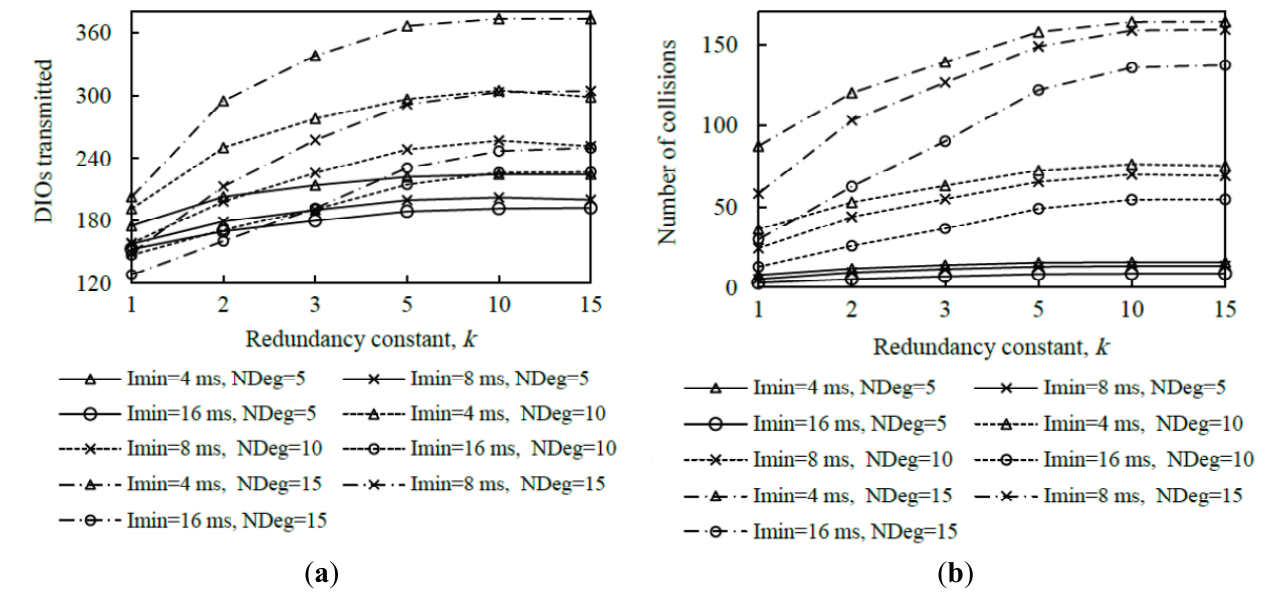
Figure 12. Average number of DIO messages transmitted and collisions in the medium network scenario for different average node degrees, as a function of the redundancy constant, k , for different values of I . min